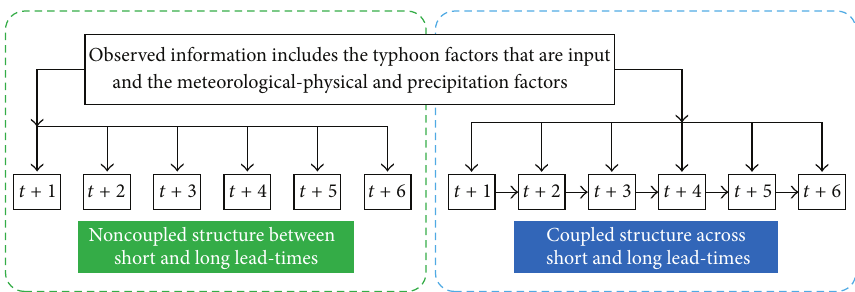
Figure 5: Noncoupled and coupled structures for precipitation forecast regarding short to long lead-time forecasting horizons.